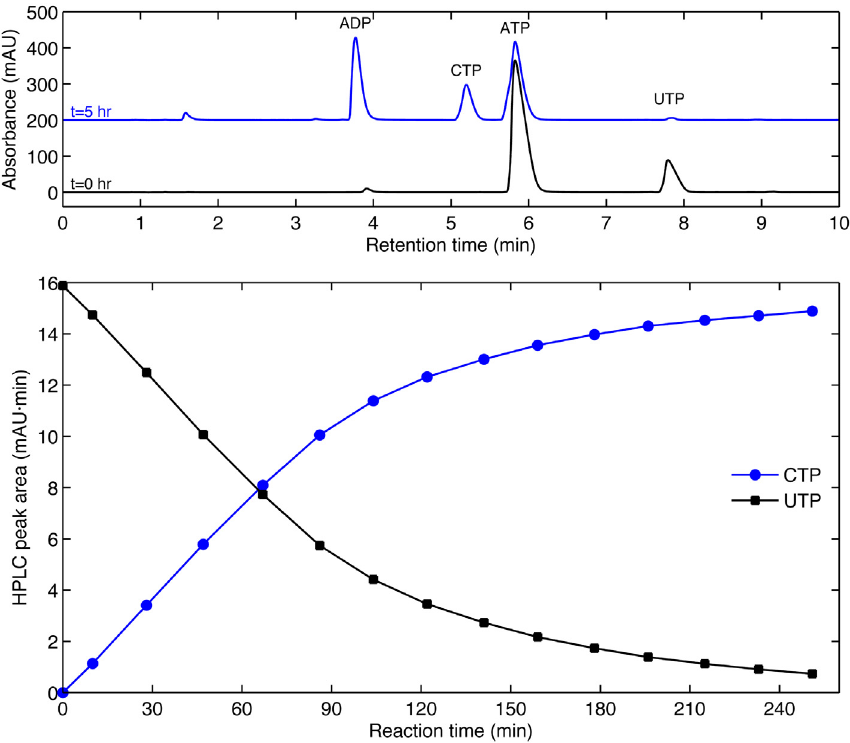
Figure 6. (A) Analytical HPLC chromatograms of the CTPS assay reaction mixture at 0 h (black trace) and 5 h (blue trace) after initiating the reaction. (B) HPLC peak area analysis of the CTPS reaction time-course. CTP, blue curve; UTP, black curve.